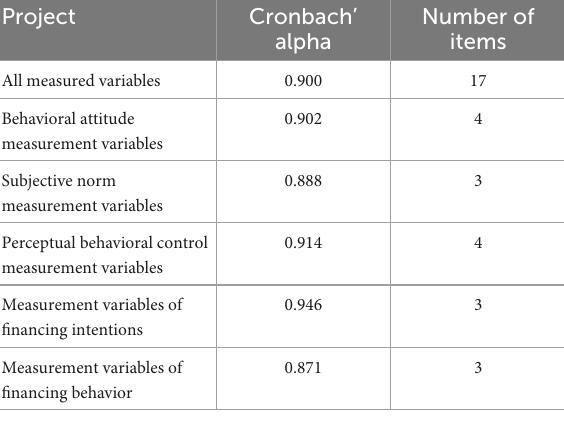
TABLE 4 Kaiser–Meyer–Olkin and Bartlett test results.